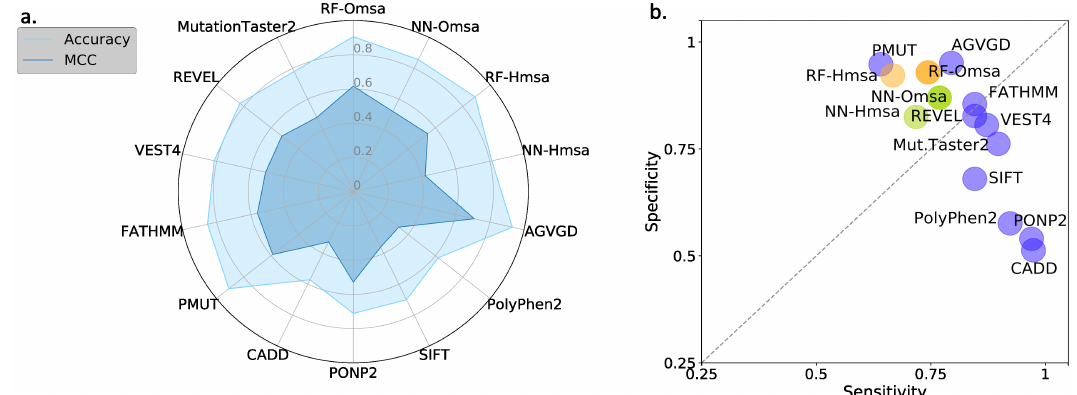
Figure 9. Performances of the standard pathogenicity predictors for the BRCA2 variants, described using four standard parameters: ( a ) Accuracy/MCC, and ( b ) sensitivity/specificity. Here, we compare the performances of ten well-known pathogenicity predictors with that of a family of RF and NN predictors for BRCA2. The RF/NN predictors were derived for this study using the five properties employed to characterize the variants and a set of BRCA2 variants with known pathogenicity annotations (see Materials and Methods). We added Hmsa and Omsa to their names to indicate the origin of the msa utilized to compute the conservation-based